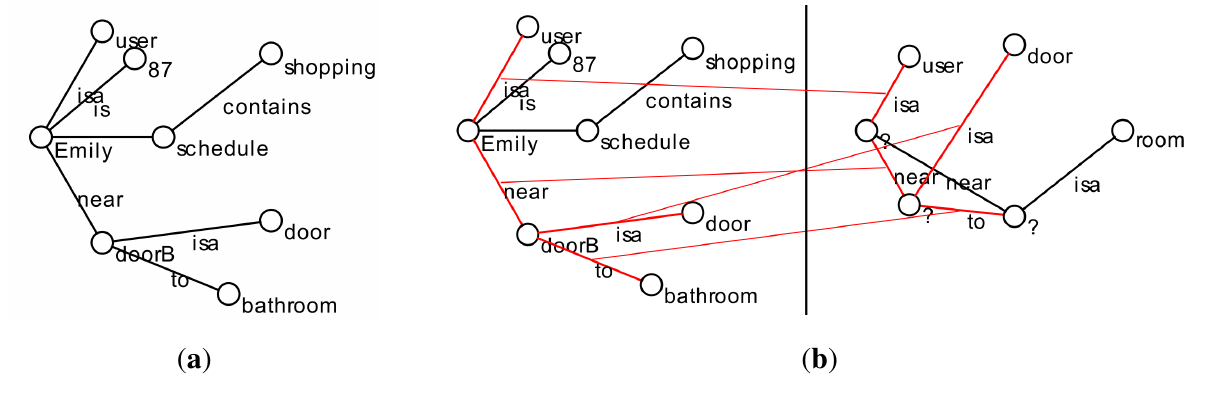
Figure 6. ( a ) Graphical representation of a graph. ( b ) Graphical representation of a